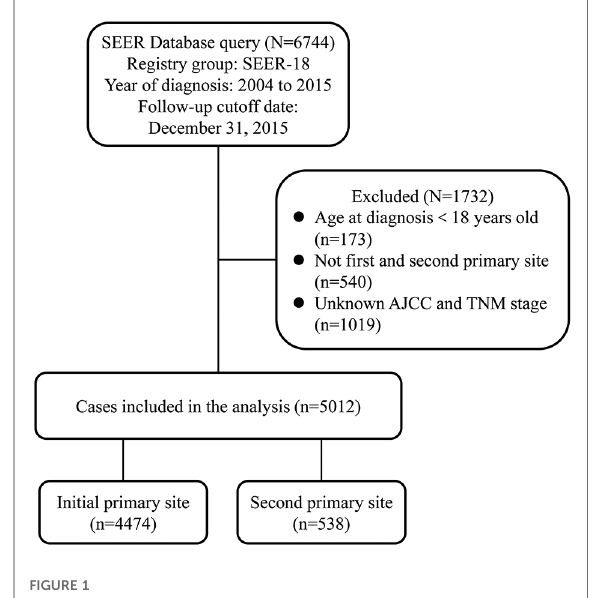
FIGURE 1 Flowchart describing the inclusion and exclusion of